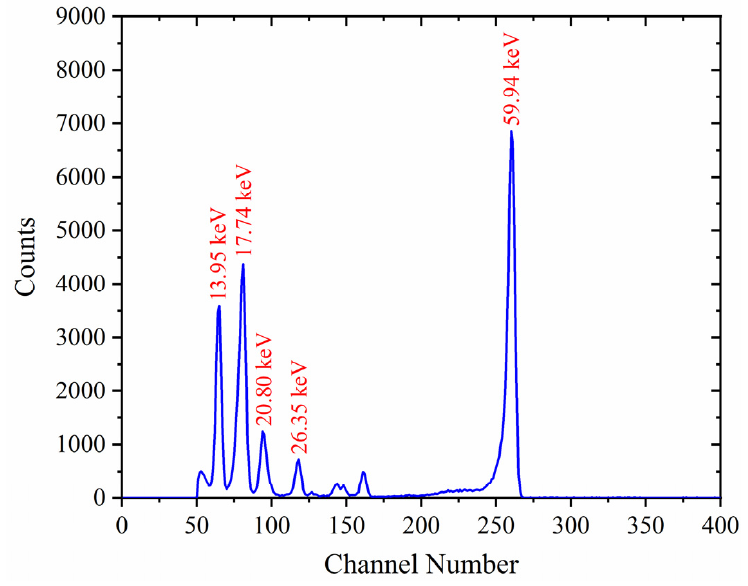
Figure 9. Spectrometer calibration with Am-241. The quartz window was located in the middle of the cavity. Because the spectrometer cannot directly face the gap between adjacent electrodes in the quadrilateral cavity, the spectrometer and the quartz window were at a 45-degree angle to obtain as many counts as possible, as shown in Figure 10.